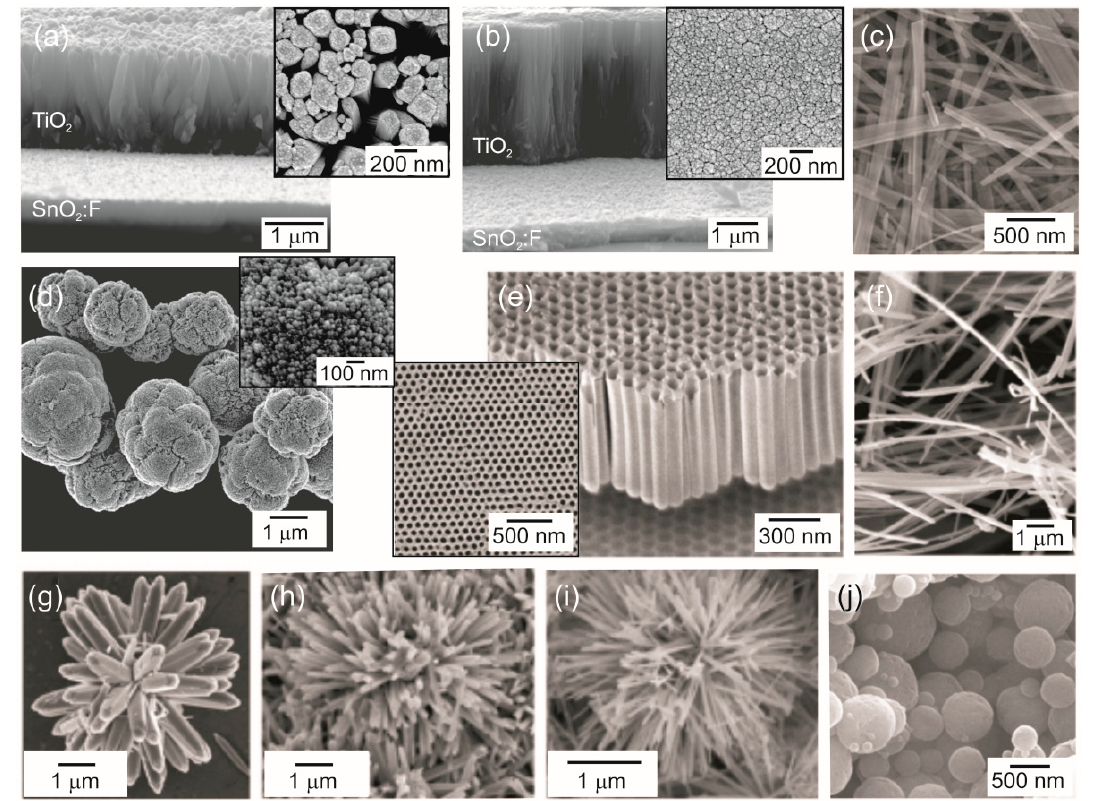
Figure 4. SEM images of several TiO 2 nanostructures. ( a , b ) TiO 2 nanorods grown of a SnO 2 :F seed layers [38], ( c ) TiO 2 nanobelts [174], ( d ) TiO 2 nanorods aggregated to form micro-sized spheres [37], ( e ) TiO 2 nanotubes formed by anodization [175], ( f ) TiO 2 nanowires [176], ( g – i ) different types of TiO 2 nanoflowers [155], and ( j ) TiO 2 nanospheres [156]. Reproduced with permission of Elsevier [38,156,174–176], MDPI [37] and Springer Nature [155] .